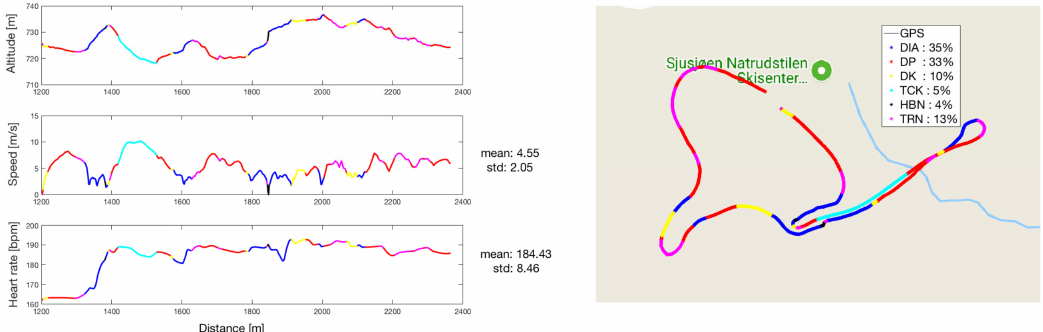
Figure 6. The dataset from subject 1 at Natrudstilen plotted as a GNSS trajectory (to the right) with subclasses indicated by color. The plots to the left display the height (altitude), speed and heart rate with sub-classes indicated by